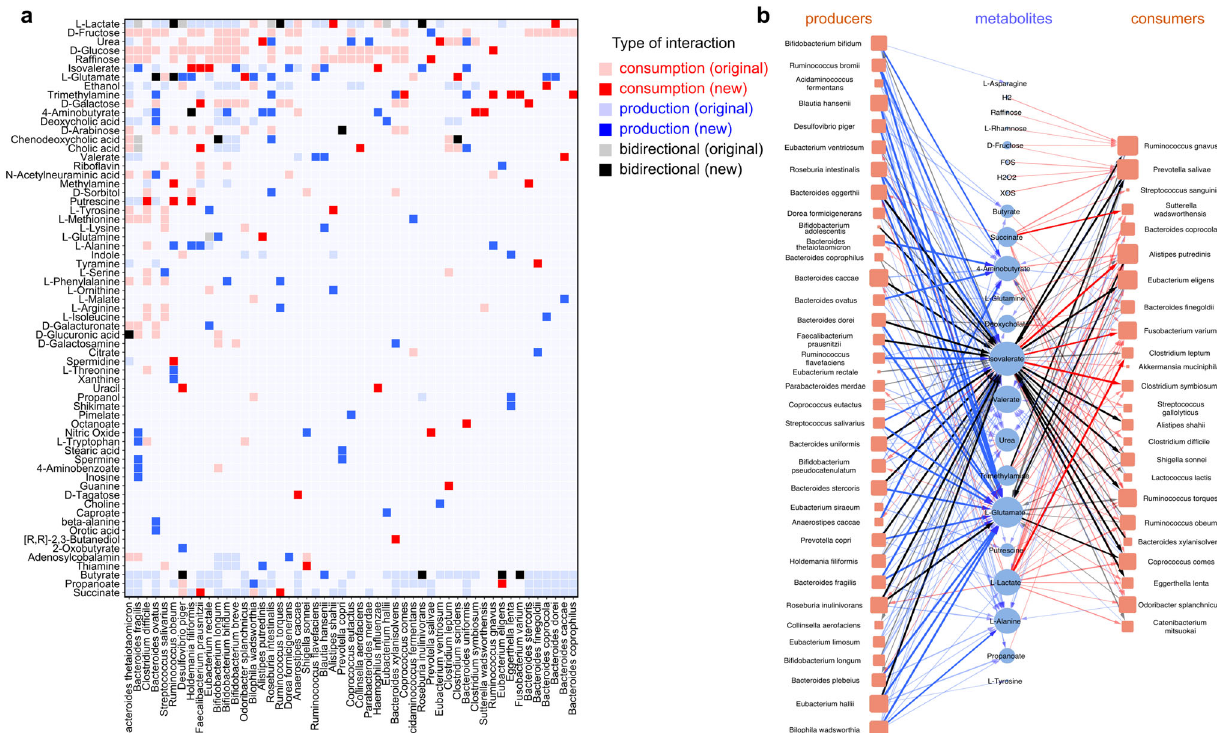
Fig. 3 New cross-feeding interactions predicted by GutCP. a Concise matrix representation of the improved cross-feeding network of the gut microbiome predicted by GutCP (the trajectory example in Fig. 2a with the best performance). The rows are metabolites, and columns, microbial species. Faded cells represent the original, known set of cross-feeding interactions, both production (light blue), consumption (light red), and bidirectional links (gray). The new cross-feeding interactions predicted by GutCP are shown in dark colors: production links in dark blue, consumption links in dark red, and bidirectional links in black. b Network of 293 new links predicted by GutCP (with a P value < 10 − 3 , one-sided binomial test) during 100 independent simulations. Blue nodes represent metabolites, orange is bacteria as in Fig. 1. The size of each node represents its degree. The color of the links is the same as in ( a ), while the color intensity and link thickness are proportional to the link ’ s con fi dence, or P value. For bidirectional links, we represent the direction as that of the link with the smaller P